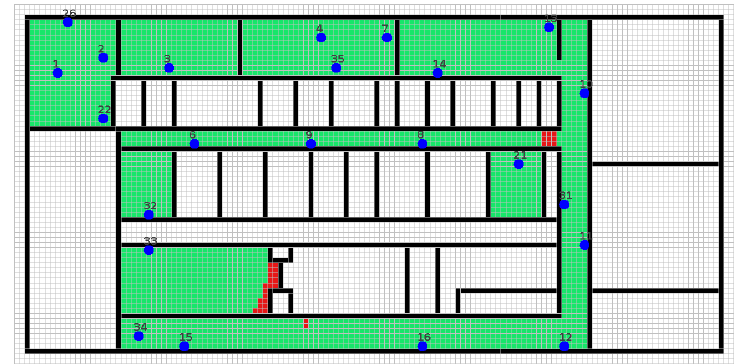
Figure 6. WSN deployment on the ground floor of the Cork Institute of Technology (CIT-G).